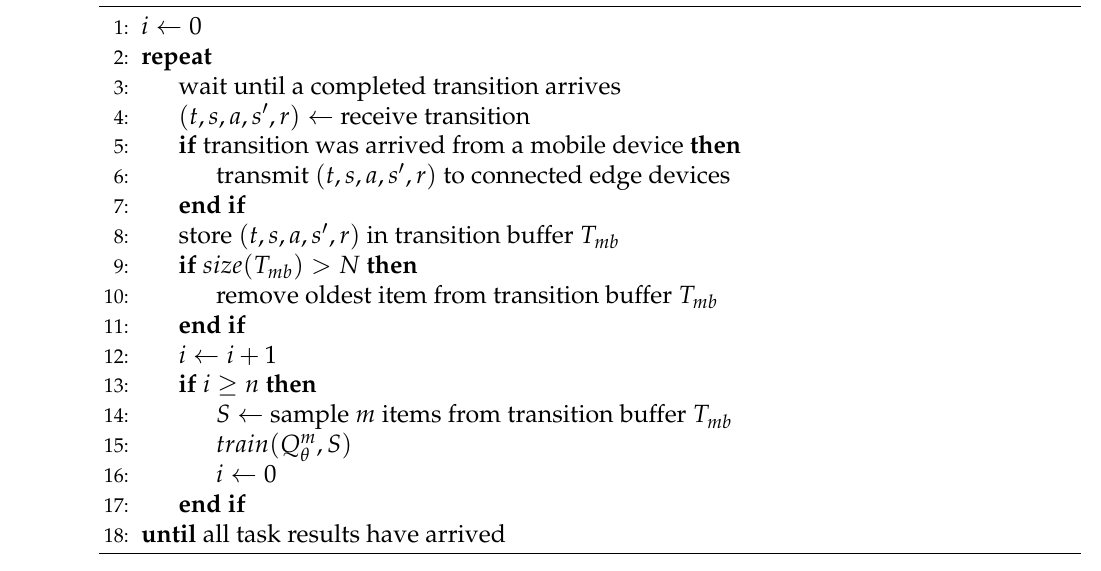
Algorithm 7 Q-training algorithm in edge devices for connected mobile devices